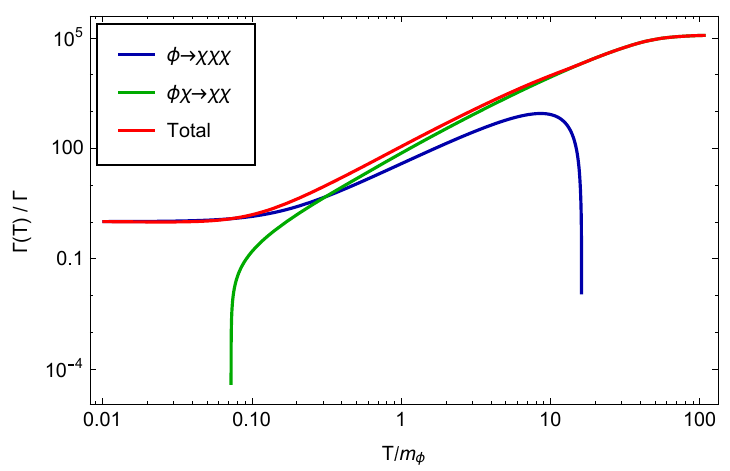
Figure 8. The temperature dependence of the dissipation rate of the in(cid:13)aton (cid:12)eld for the in- teraction h(cid:30)(cid:31) 3 = 3! and the self-interaction (cid:21)(cid:31) 4 = 4!, see eq. (3.6). The red line indicates the total dissipation rate, the blue and green line indicate the 3-body decay (cid:30) ! (cid:31)(cid:31)(cid:31) and scatterings (cid:30)(cid:31) ! (cid:31)(cid:31) , respectively. Here we choose the self-coupling constant of (cid:31) -particles as (cid:21) = 0 : 01. The temperature is normalised by in(cid:13)aton mass and the decay rate by its vacuum value (i.e. at zero